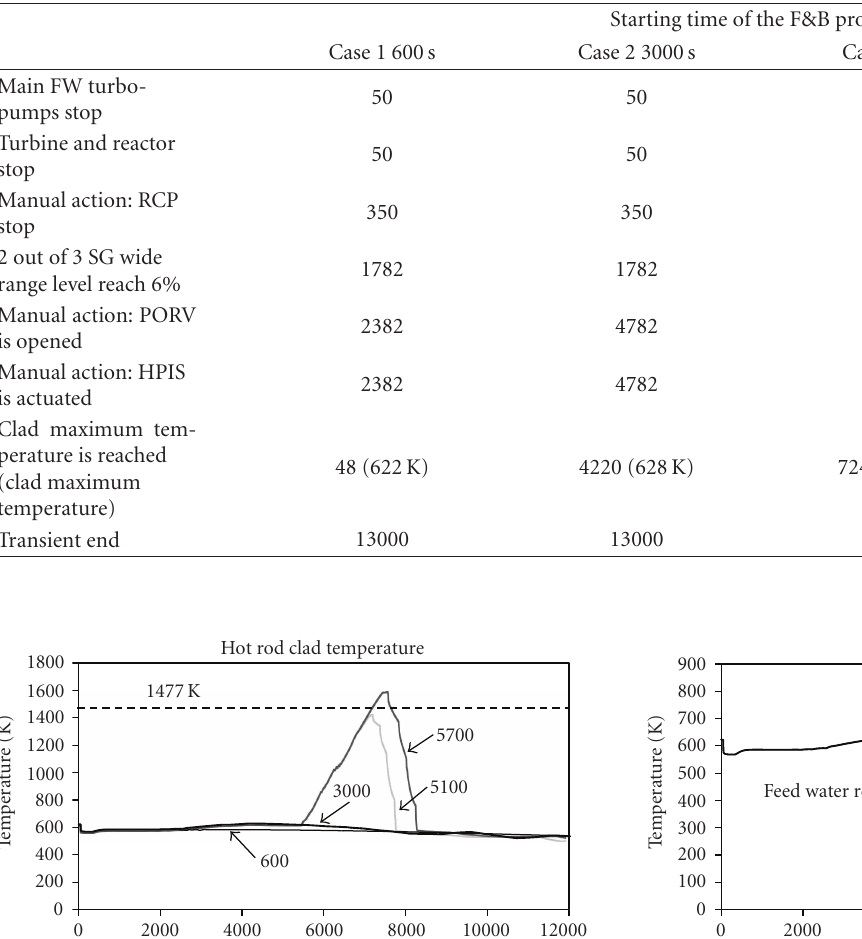
Table 3: Features of selected transients (F&B starting time analysis).